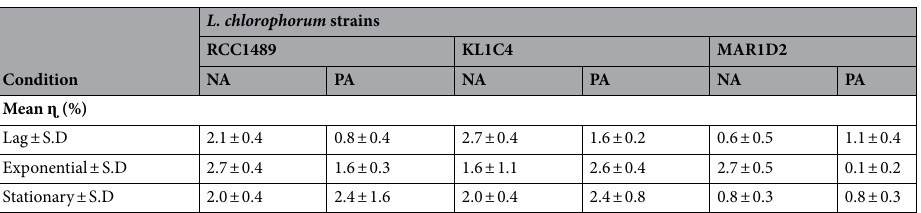
Table 2. Mean relative excess viscosity ɳ (%) during each growth phase under non-axenic (NA) and pseudo- axenic (PA) conditions (n = 9) for the three studied L. chlorophorum strains (RCC1489, KL1C4 and MAR1D2).